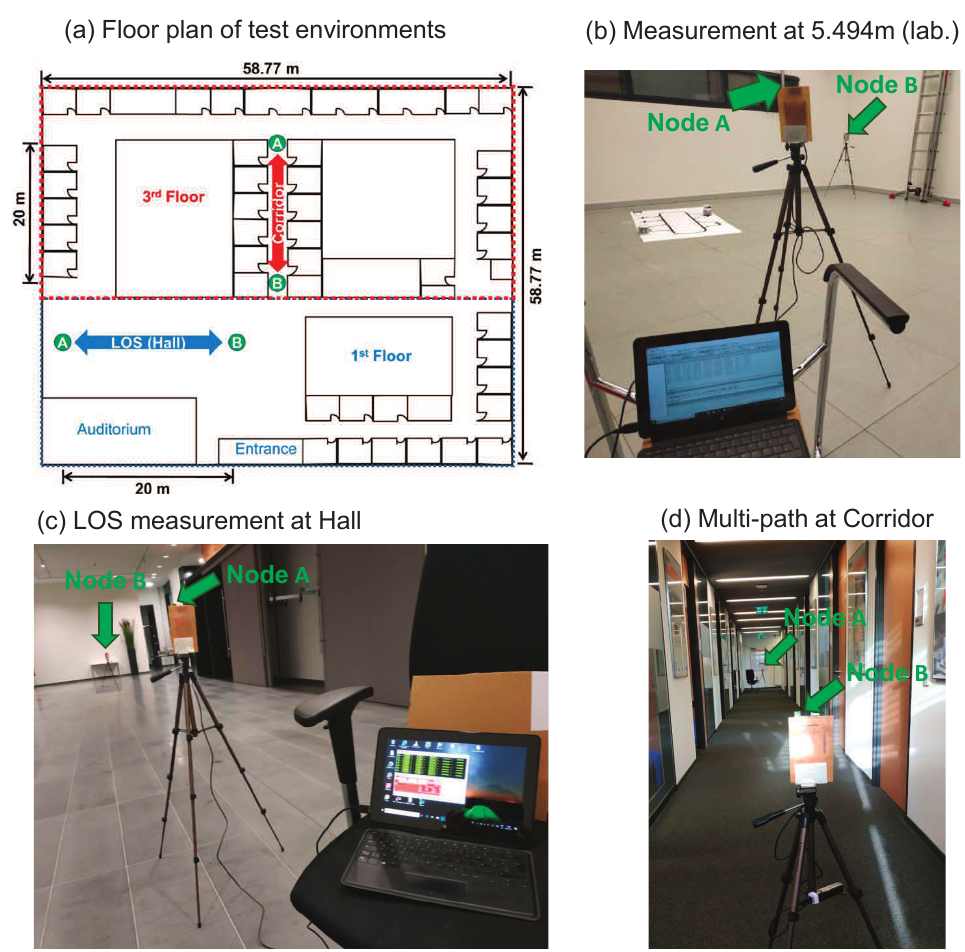
Figure 6. Test environments of the experimental evaluations: ( a ) overview of office floor plan for the LOS experiment in hall (blue arrow) and the multipath experiment in a corridor (red arrow), ( b ) fixed-distance experiment in the laboratory, ( c ) LOS experiment in a hall (office environment), and ( d ) multipath experiment in a corridor (office